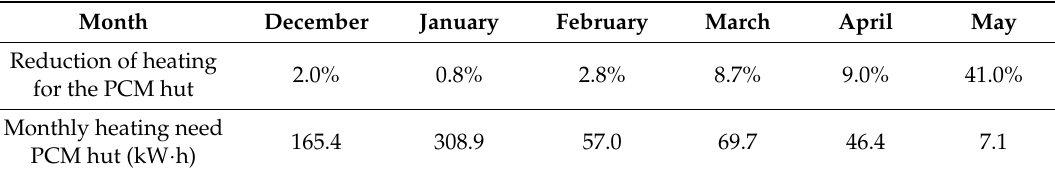
Table 4. Energy savings and energy consumption for the PCM hut for several